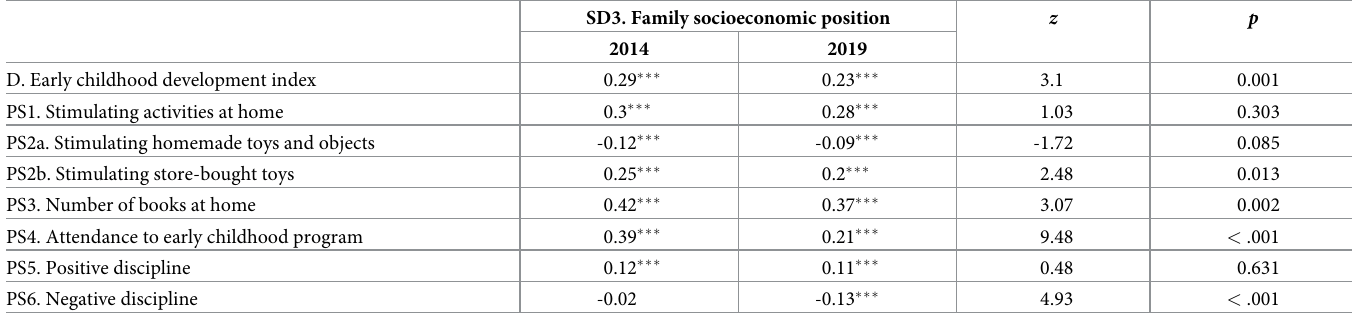
Table 3. Comparison of correlation magnitudes between family socioeconomic position and other variables in 2014 vs.